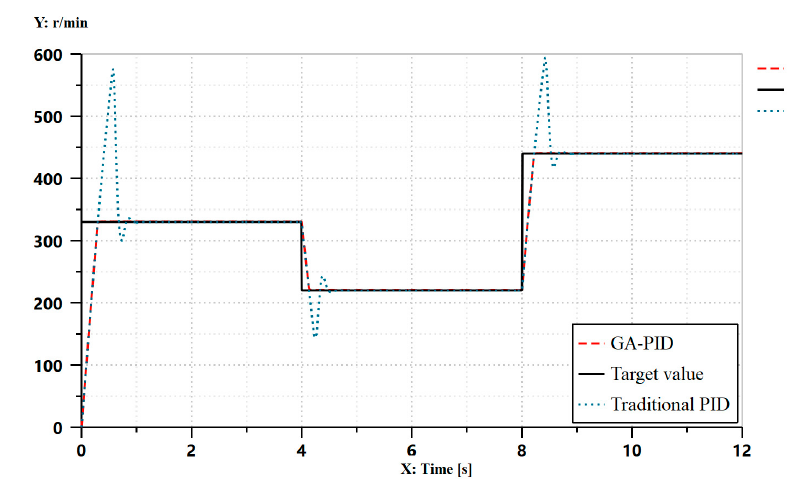
Figure 9. Rotation speed control under the coal hardness of sudden change. Table 5. Simulation data of rotation speed under the coal hardness of sudden change.